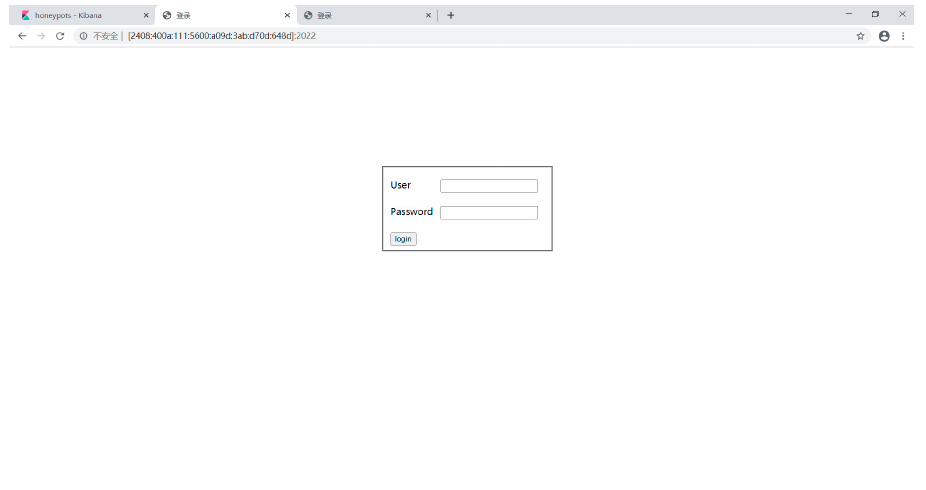
Figure 4; a SQL injection application port with 2023, http: // [2408:400a:111:5600:a09d:3ab:d70d:648d]:2023